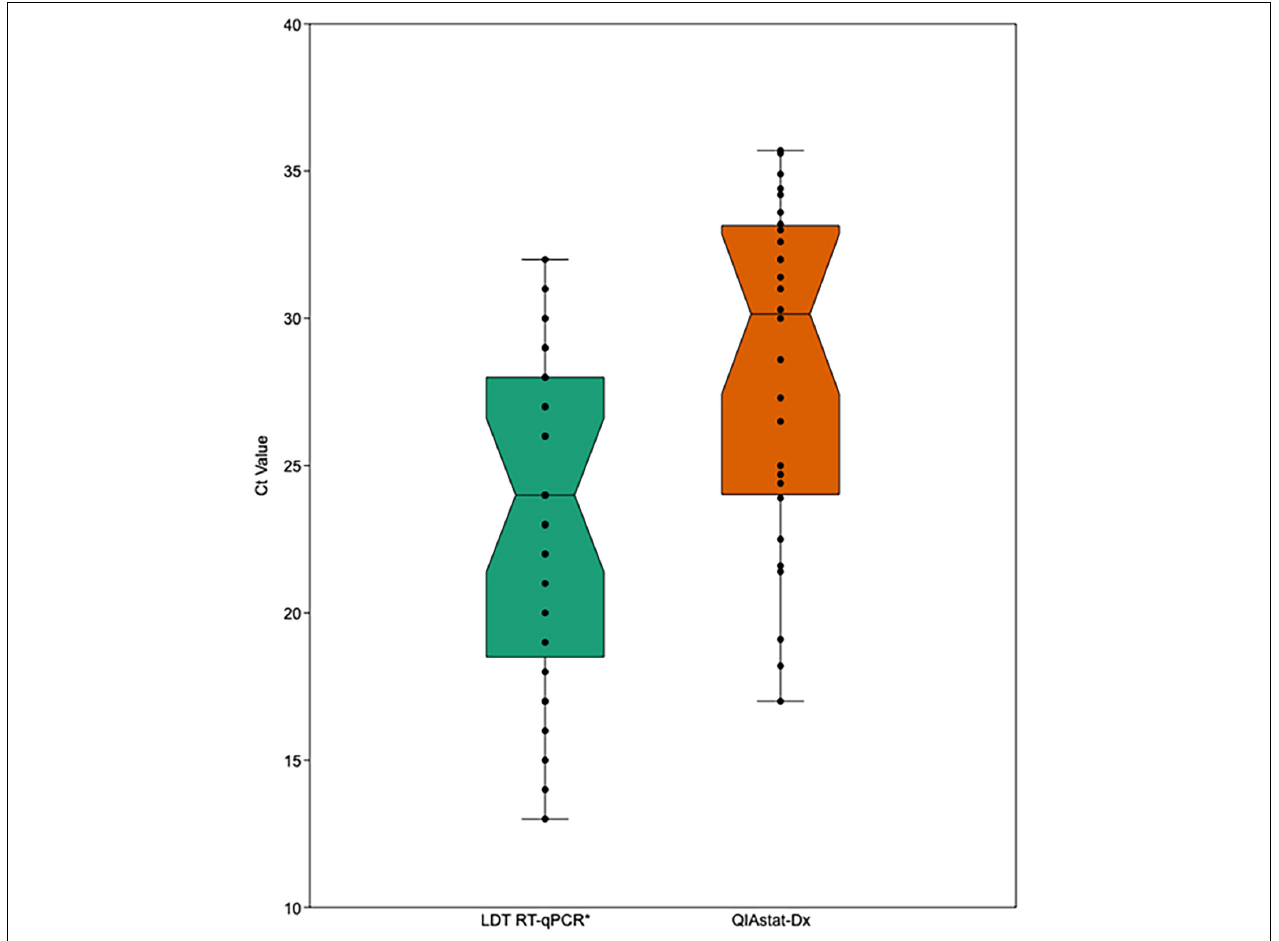
FIGURE 2 | Comparison of SARS-CoV-2 Ct values from the LDT RT-qPCR and the QIAstat-Dx (RP2.0). The box represents the upper and lower quartiles, the horizontal line represents the median and the standard error is shown by upper and lower whisker lines. LDT, laboratory developed test; Ct, cycle threshold. *Gold-standard.